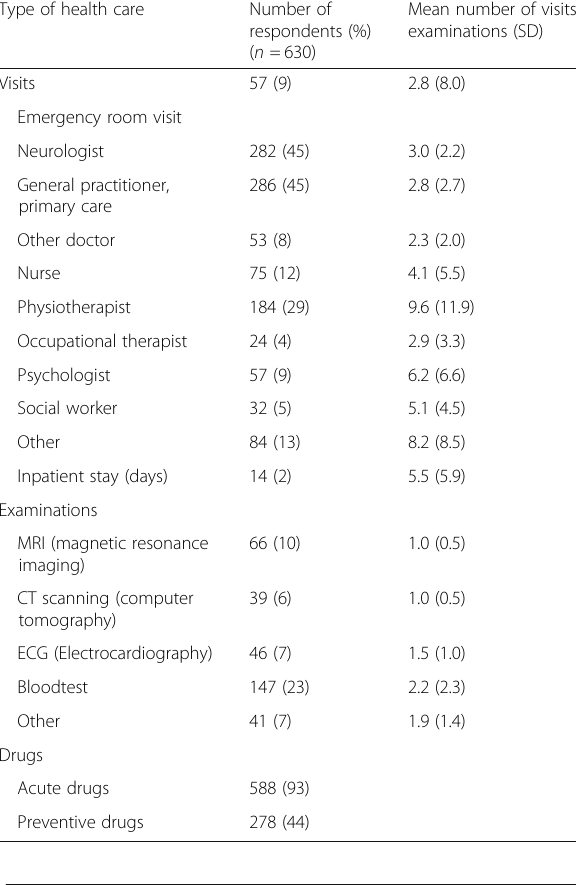
Table 2 Health care visits, examinations and drugs related to migraine during the last 12 months